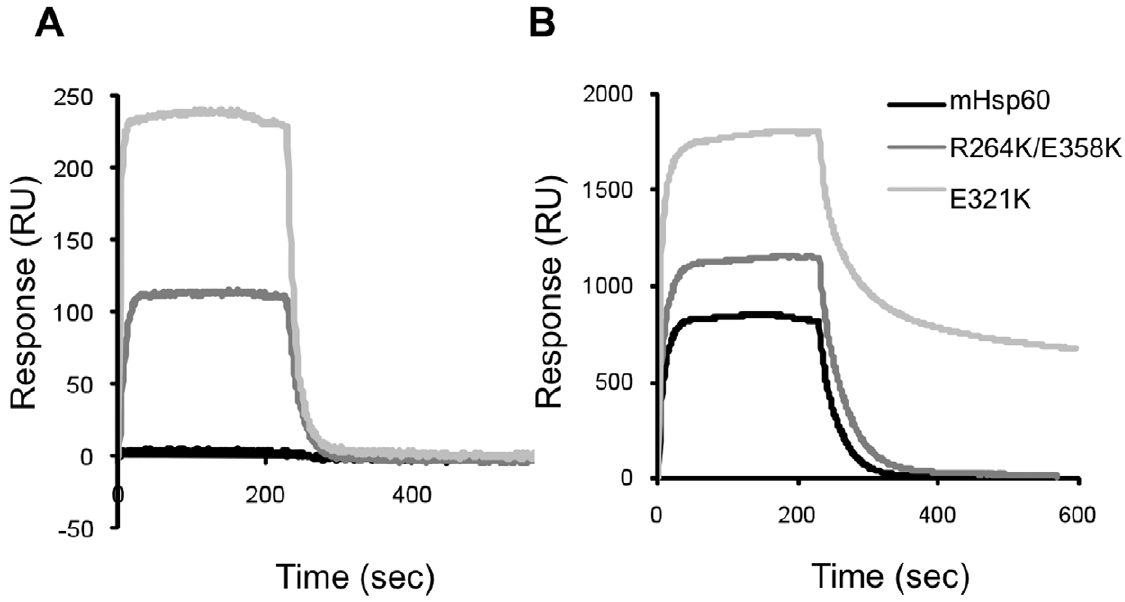
Figure 6. Chaperonin-co-chaperonin interactions measured by SPR. Association and dissociation patterns of 10 m M of the indicated chaperonin to immobilized (A) GroES ( , 600 Relative Units-RU) or (B) mHsp10 ( , 800 RU) in the presence of 2 mM ATP.